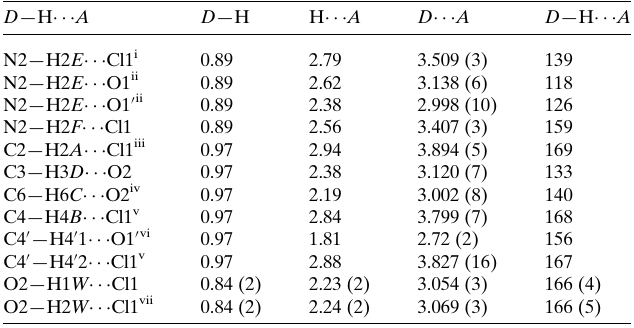
Table 1 Hydrogen-bond geometry (A˚ , (cid:3)